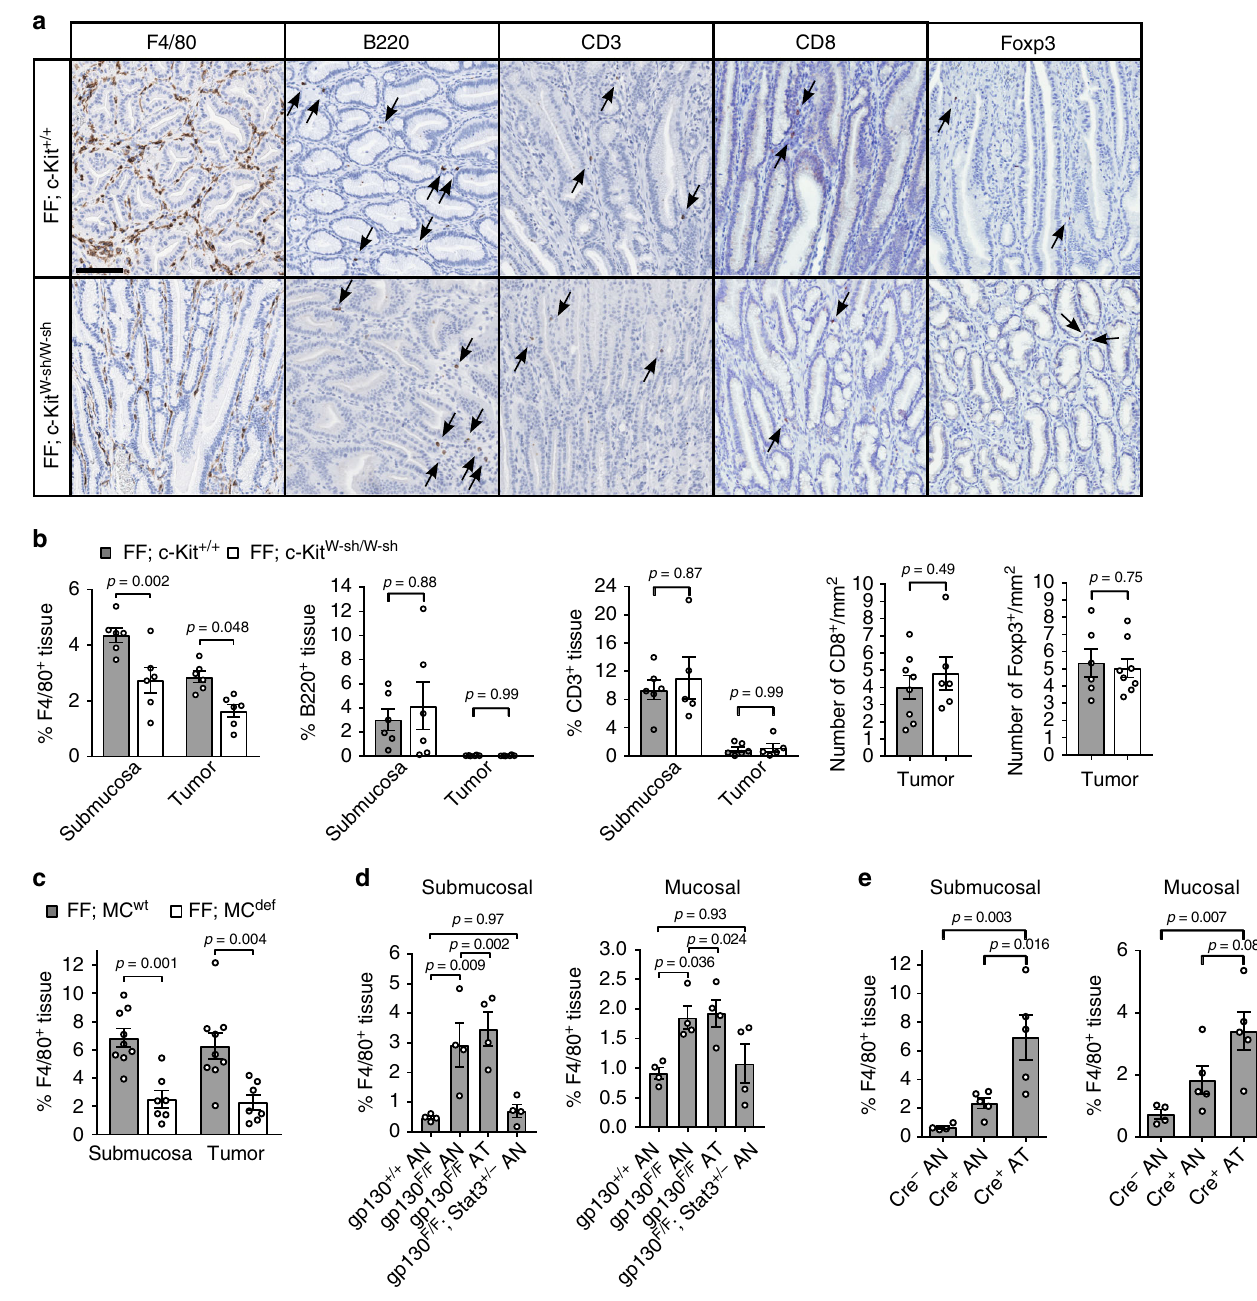
Fig. 3 Mast cell depletion reduces macrophage in fi ltration in gastric tumors of gp130 FF mice. a Representative images of tissue sections immunostained for macrophages (F4/80), B cells (B220) or T cells (CD3, CD8, Foxp3) in gastric tumor sections of gp130 FF ; c-Kit + / + and mast cell-de fi cient gp130 FF ; c-Kit W- sh/W-sh mice. Arrows indicate speci fi c positive cell staining; scale bars = 100 µ m. b Quanti fi cation of F4/80, B220, or CD3 expressing cells in tumor